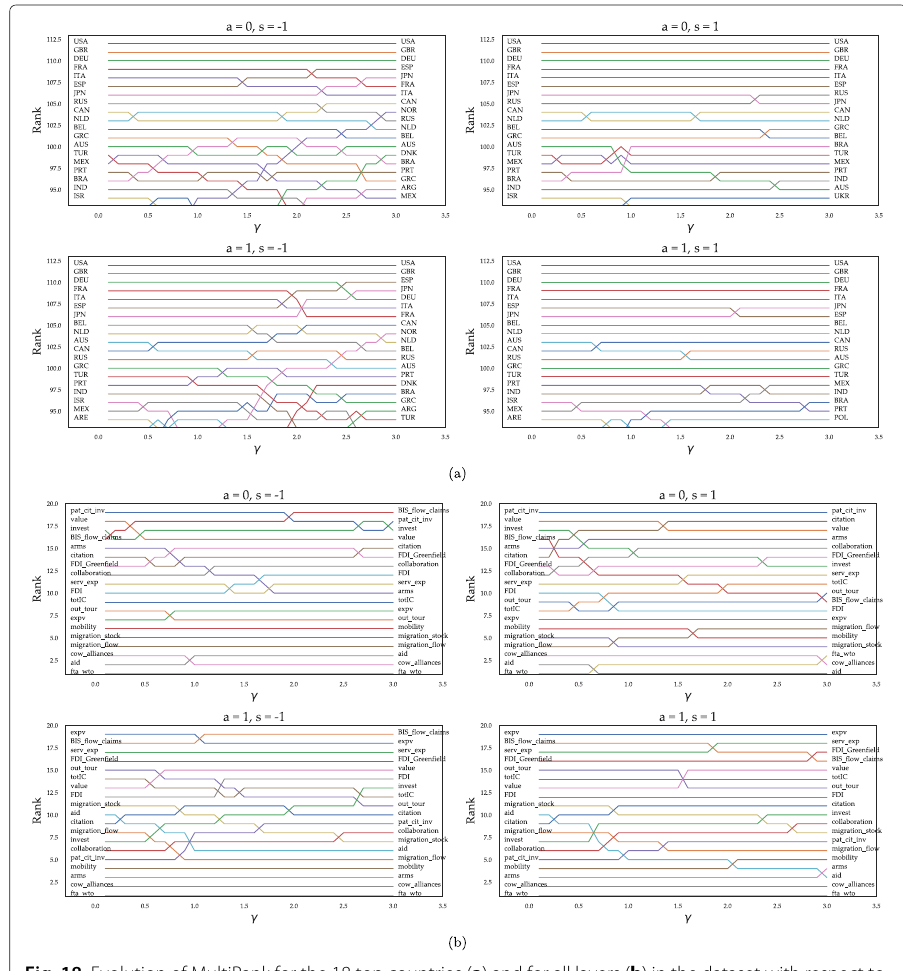
Fig. 18 Evolution of MultiRank for the 18 top countries ( a ) and for all layers ( b ) in the dataset with respect to different parameters choice